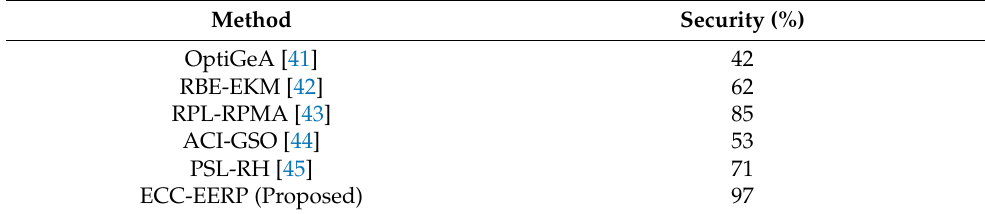
Table 3. Security of the proposed and existing methods.